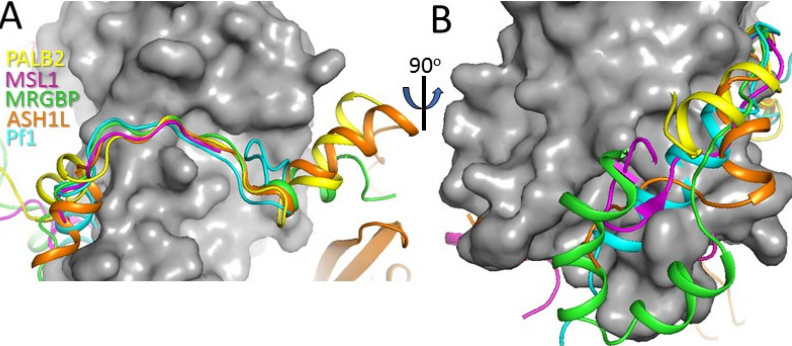
Figure 6. Comparison of PALB2 peptide conformation with other MRG-binding peptides. Two orthogonal views of MRG (shown in grey surface representation) complexes with PALB2 (yellow), MSL1 (magenta), MRGBP (green), ASH1L (orange) and Pf1 (cyan) shown in cartoon representations with the middle part of the peptides shown in panel ( A ) and the N-terminal parts in panel ( B ). All structures were superimposed by MRG